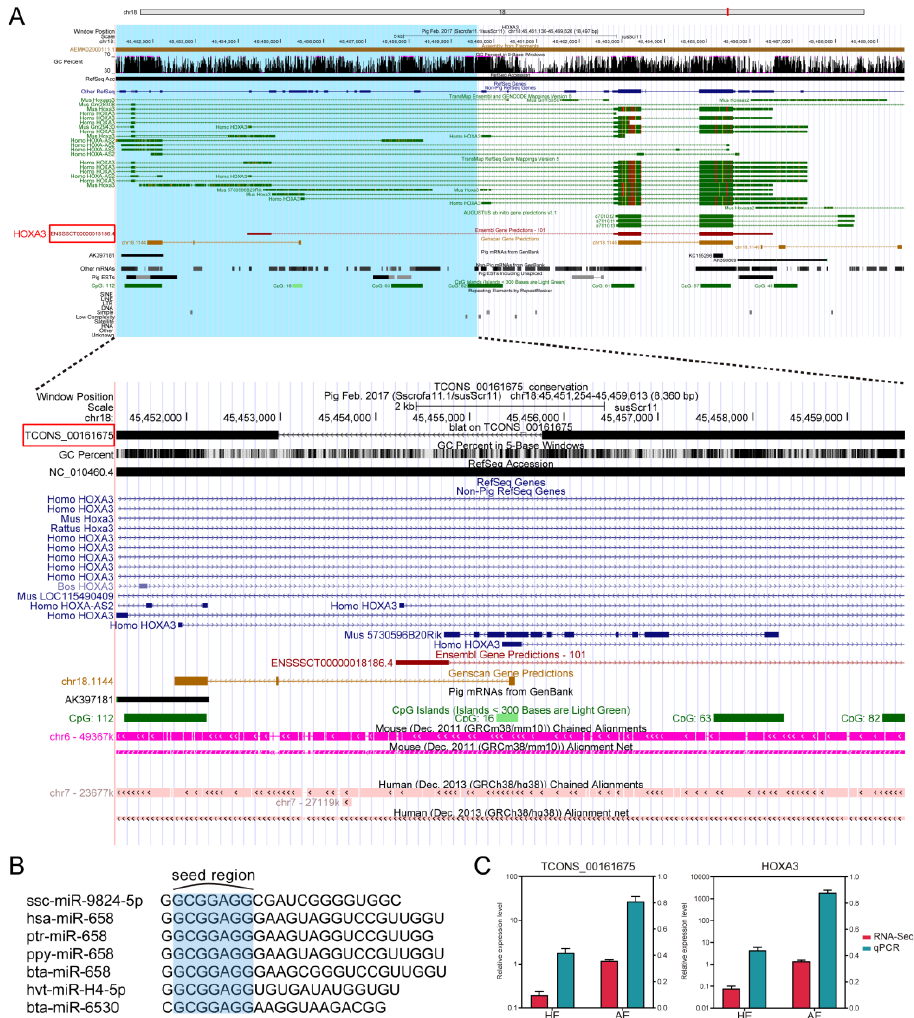
Figure 7. Assessment of lncRNA and miRNA conservation. ( A ) Schematic diagram of the 45,451,130–45,469,626 bp genome annotation of pig chromosome 18, depicted with the gene loci of HOXA3 and the identified lncRNA TCONS_00167675, which is highlighted by the red boxes. ( B ) Alignment of ssc-miR-9824-5p with miRNAs of different species in the seed region. ( C ) Relative expression levels of TCONS_00161675 and